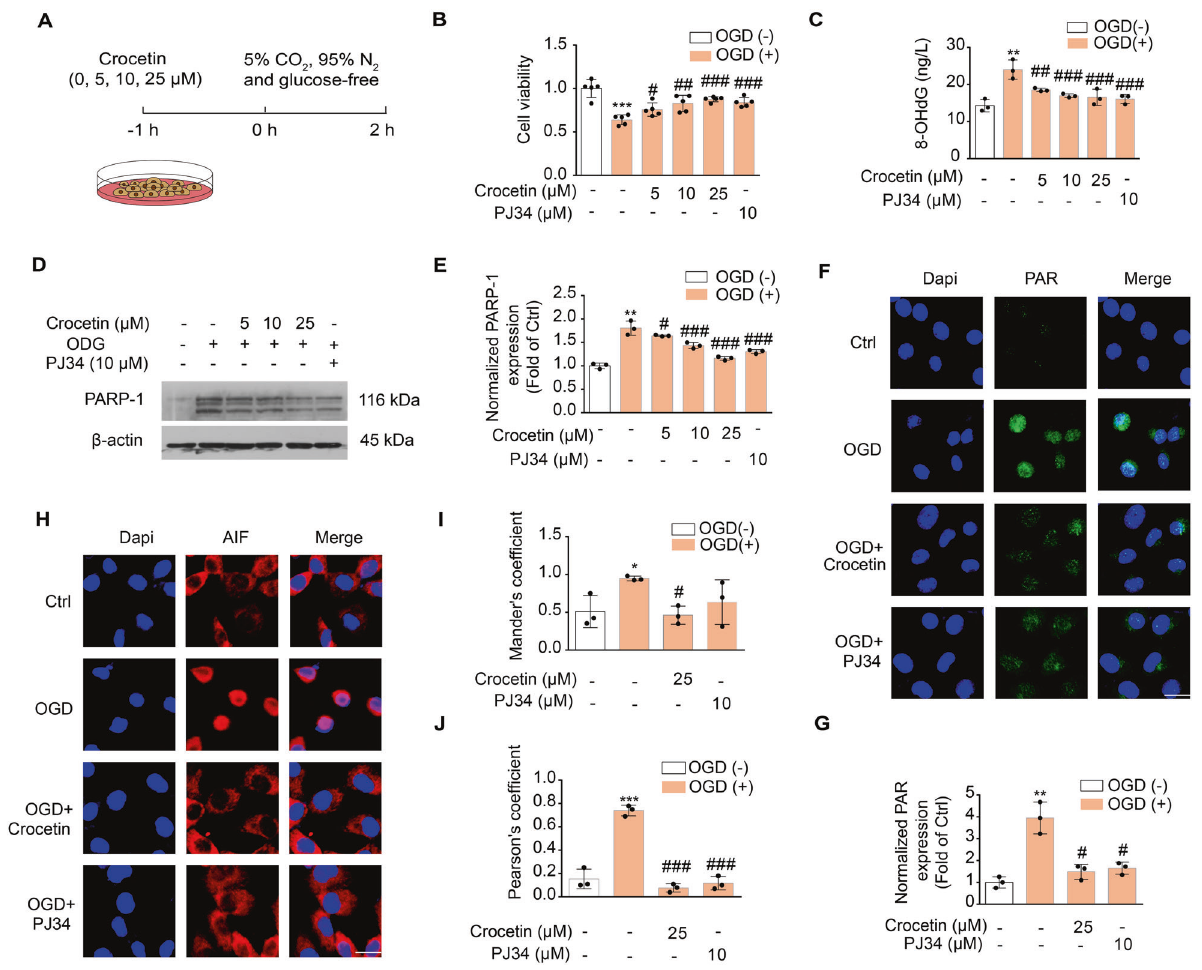
Fig. 2 Anti-parthanatos effects of crocetin in the OGD cell model. A Scheme diagram of the experiment. SH-SY5Y cells were treated with indicated concentrations of crocetin or PJ34 (PARP inhibitor, 10 μ M) for 1 h before 2 h-OGD (there is no crocetin or PJ34 treatment during OGD). B Cell viability of SH-SY5Y at the end of 2 h-OGD determined with MTT assay. C OGD-induced 8-OHdG in SH-SY5Y cells at the end of 2 h- OGD. D OGD-induced PARP-1 expression SH-SY5Y cells upon crocetin or PJ34 pre-treatment. E Group quanti fi cation of ( D ) from